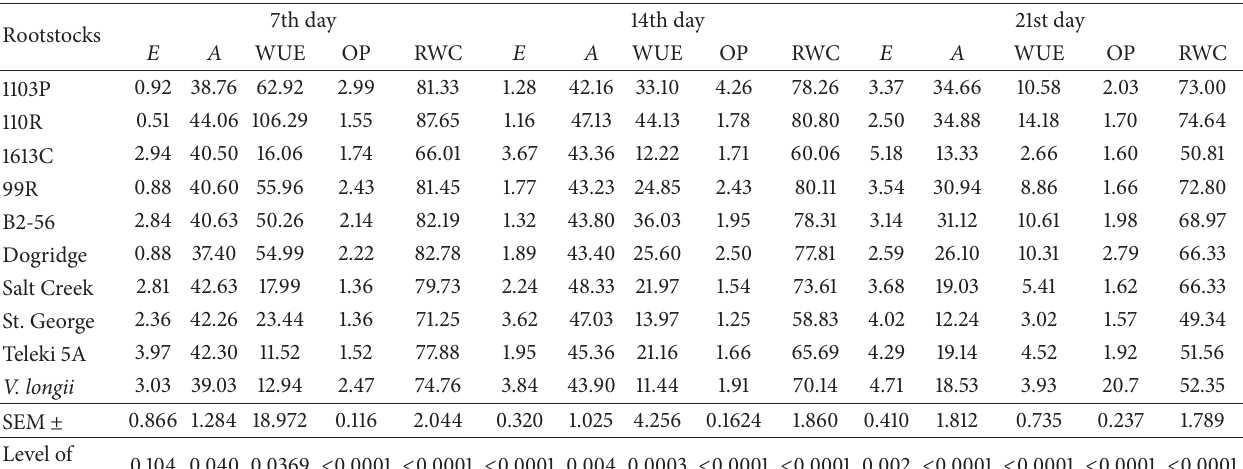
Table 2: Gas exchange and water relation parameters of grape rootstocks of different stages of 50% moisture stress cycle.